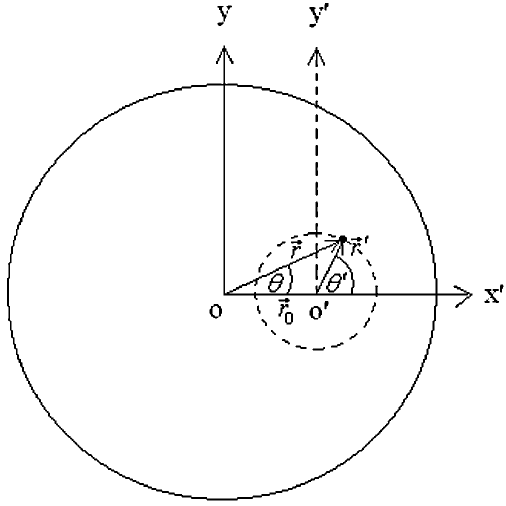
FIG. 3. Coordinate scheme for the off-axis electron injection